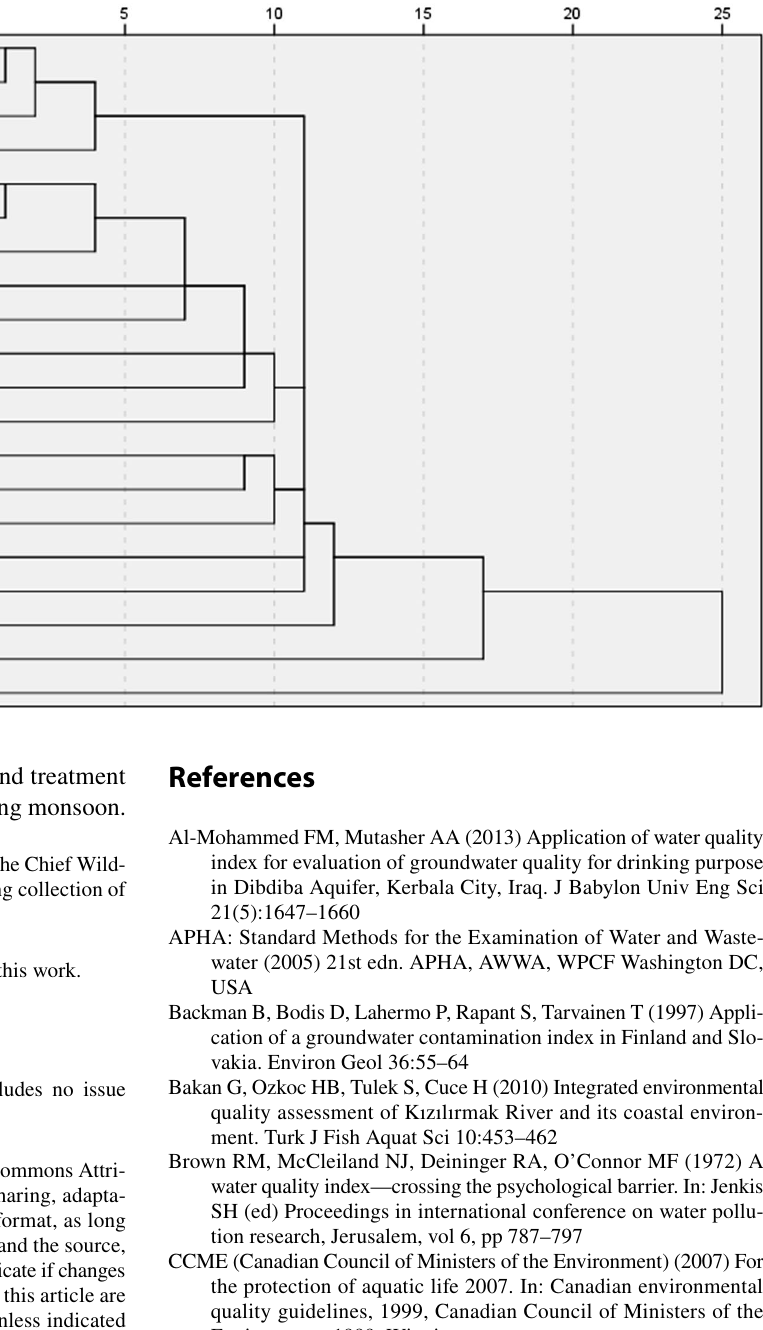
Fig. 2 Dendrogram for cluster analysis of sampling locations in Bhindawas